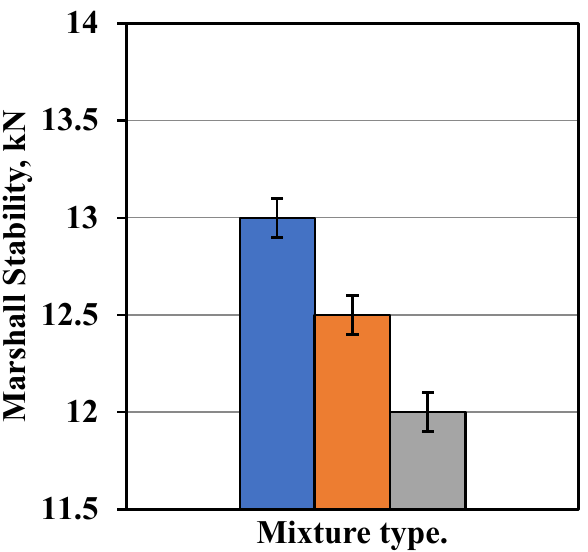
Figure 4. Results of Marshall Stability.